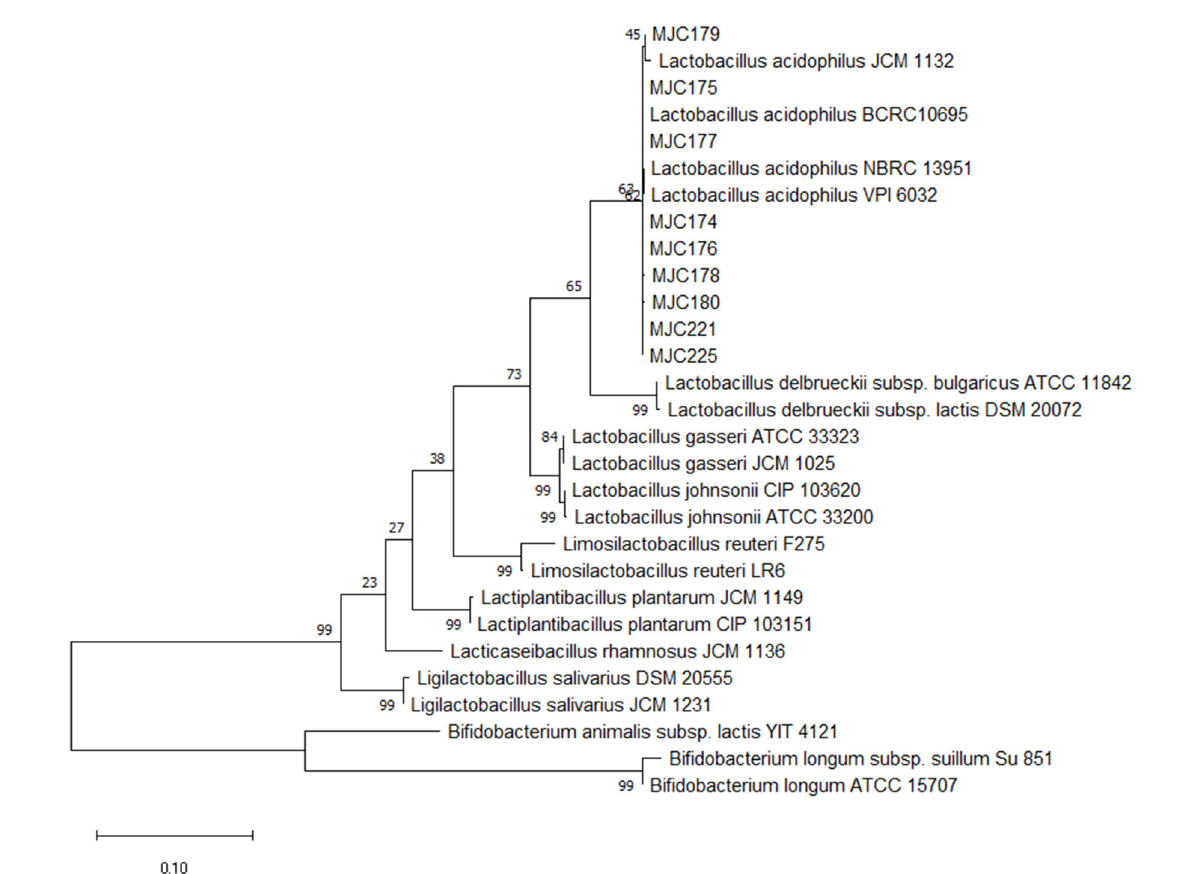
FIGURE1 Phylogenetic tree of nine isolates. The 16S rRNA gene sequences of other genus and Lactobacillus species were downloaded from NCBI, and phylogenetic analysis with the maximum likelihood method via MEGAX software with a 1,000 bootstrap was performed.